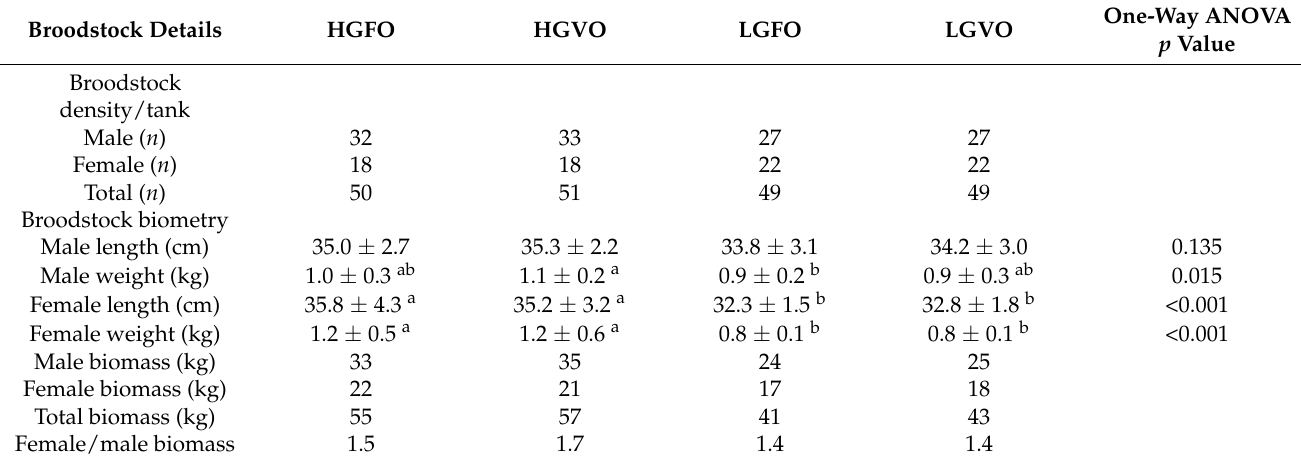
Table 1. Description of gilthead sea bream broodstock selected for mass spawning